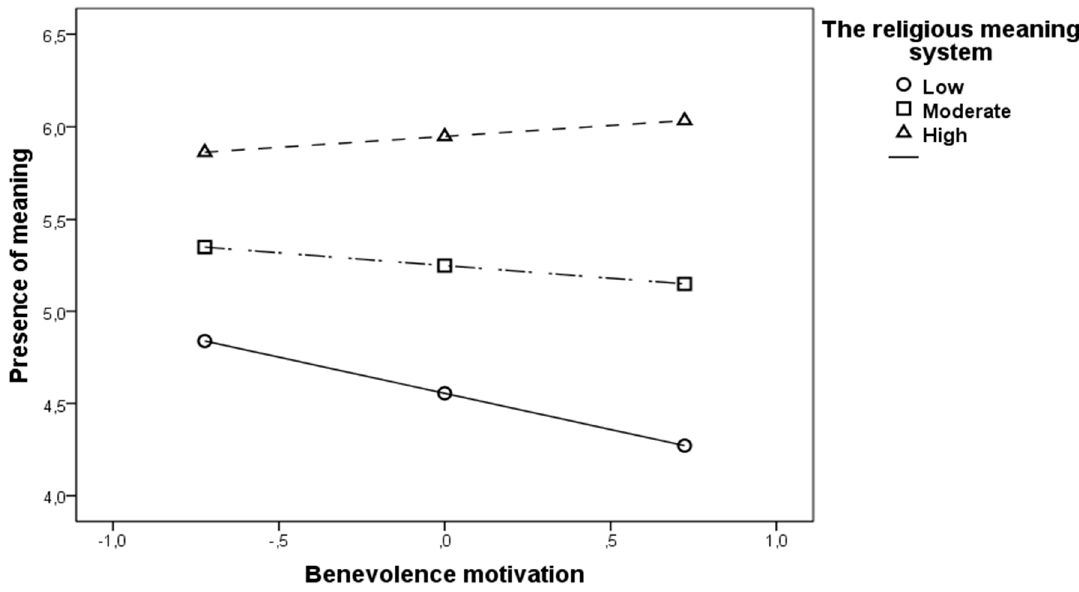
Figure 4. A visual representation of the moderation of the effect of benevolence motivation on presence of meaning at low ( − 1SD), moderate (M), and high (+1SD) levels of the religious meaning system.